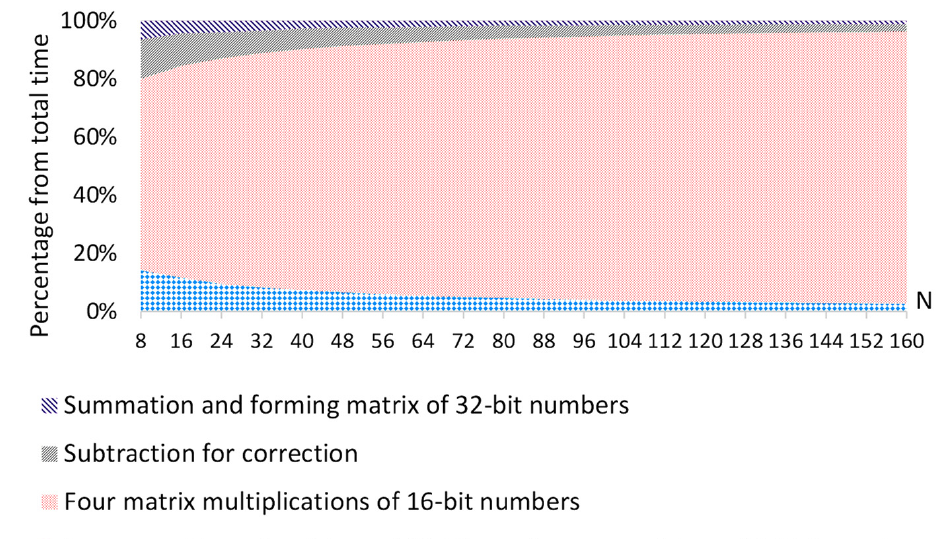
Figure 4. Scheme of matrix multiplication of 32-bit fixed point numbers (16.16) via 16-bit vector instructions.